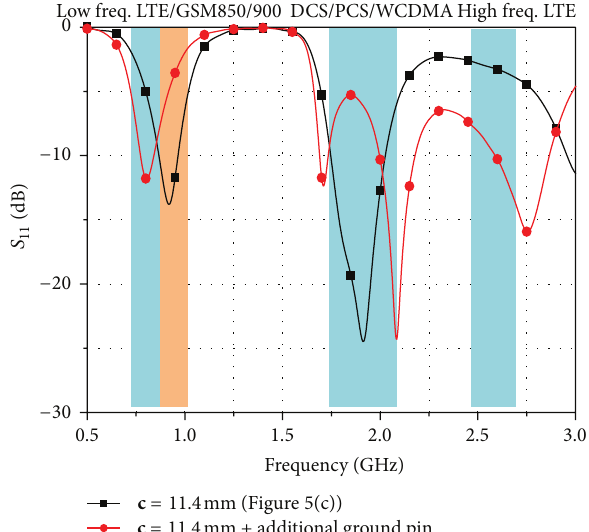
Figure 7: Simulated 𝑆 11 of the modified penta-band PIFA with the increased length of c = 11.4mm and an additional ground pin at the upper right side.